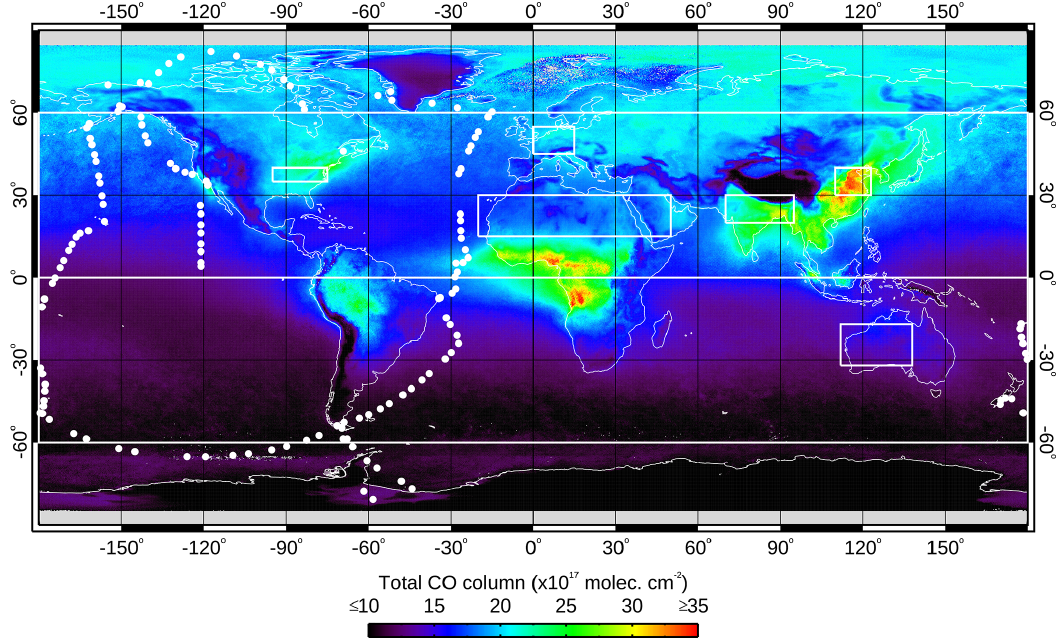
Figure 2. White rectangles show the location of the land-only ROIs analyzed: N Hemisphere (0 to 60 ◦ N), S Hemisphere (60 ◦ S to 0 ◦ N), USA (35 ◦ N, 95 ◦ W to 40 ◦ N, 75 ◦ W), Europe (45 ◦ N, 0 ◦ E to 55 ◦ N, 15 ◦ E), India (20 ◦ N, 70 ◦ E to 30 ◦ N, 95 ◦ E), China (30 ◦ N, 110 ◦ E to 40 ◦ N, 123 ◦ E), Sahara (15 ◦ N, 20 ◦ W to 30 ◦ N, 50 ◦ E), and Australia (32 ◦ S, 112 ◦ E to 17 ◦ S, 138 ◦ E). White circles indicate the location of individual CO profiles acquired in April–May 2018 during the ATom-4 airborne campaign. The background map shows mean MOPITT TIR total CO column values for